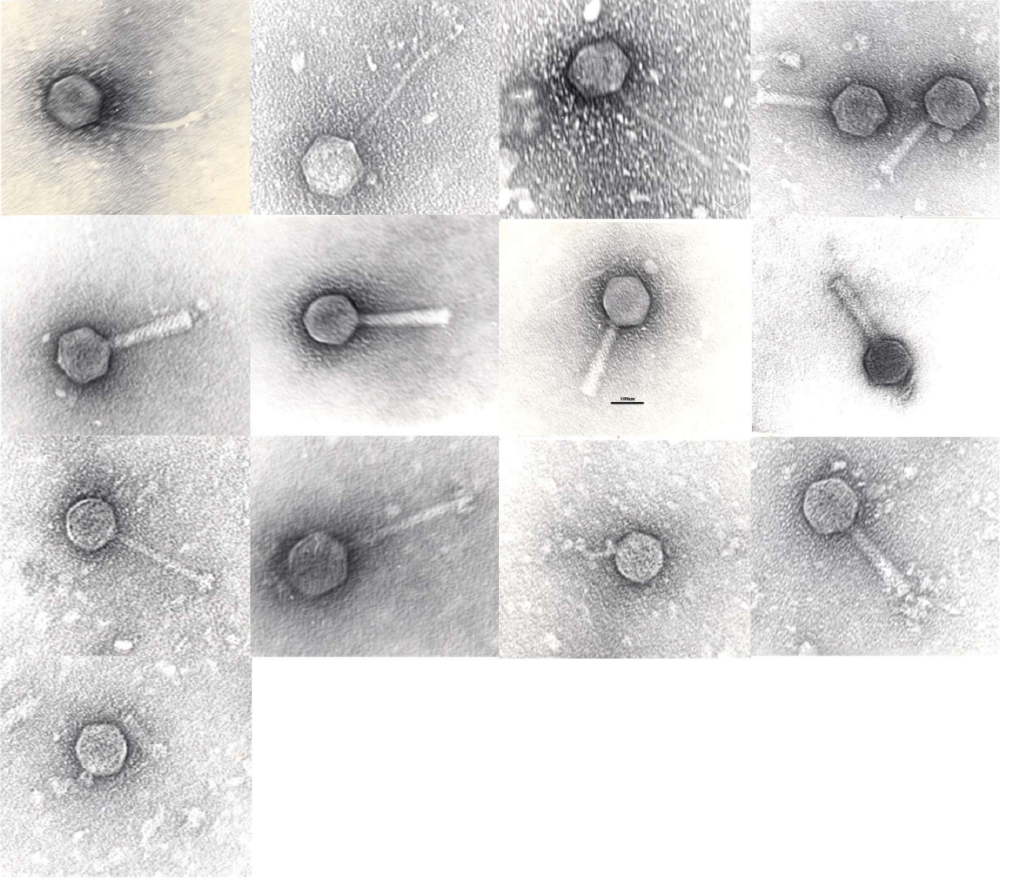
Figure 2. Tansmission electron micrographs of phages in left->right, top->bottom order: